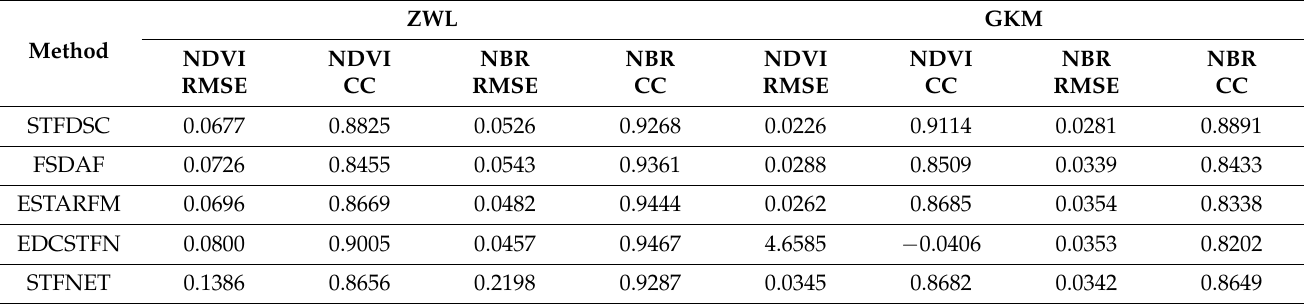
Table 3. Performances of five STF methods in reconstructing the NDVI and NBR.